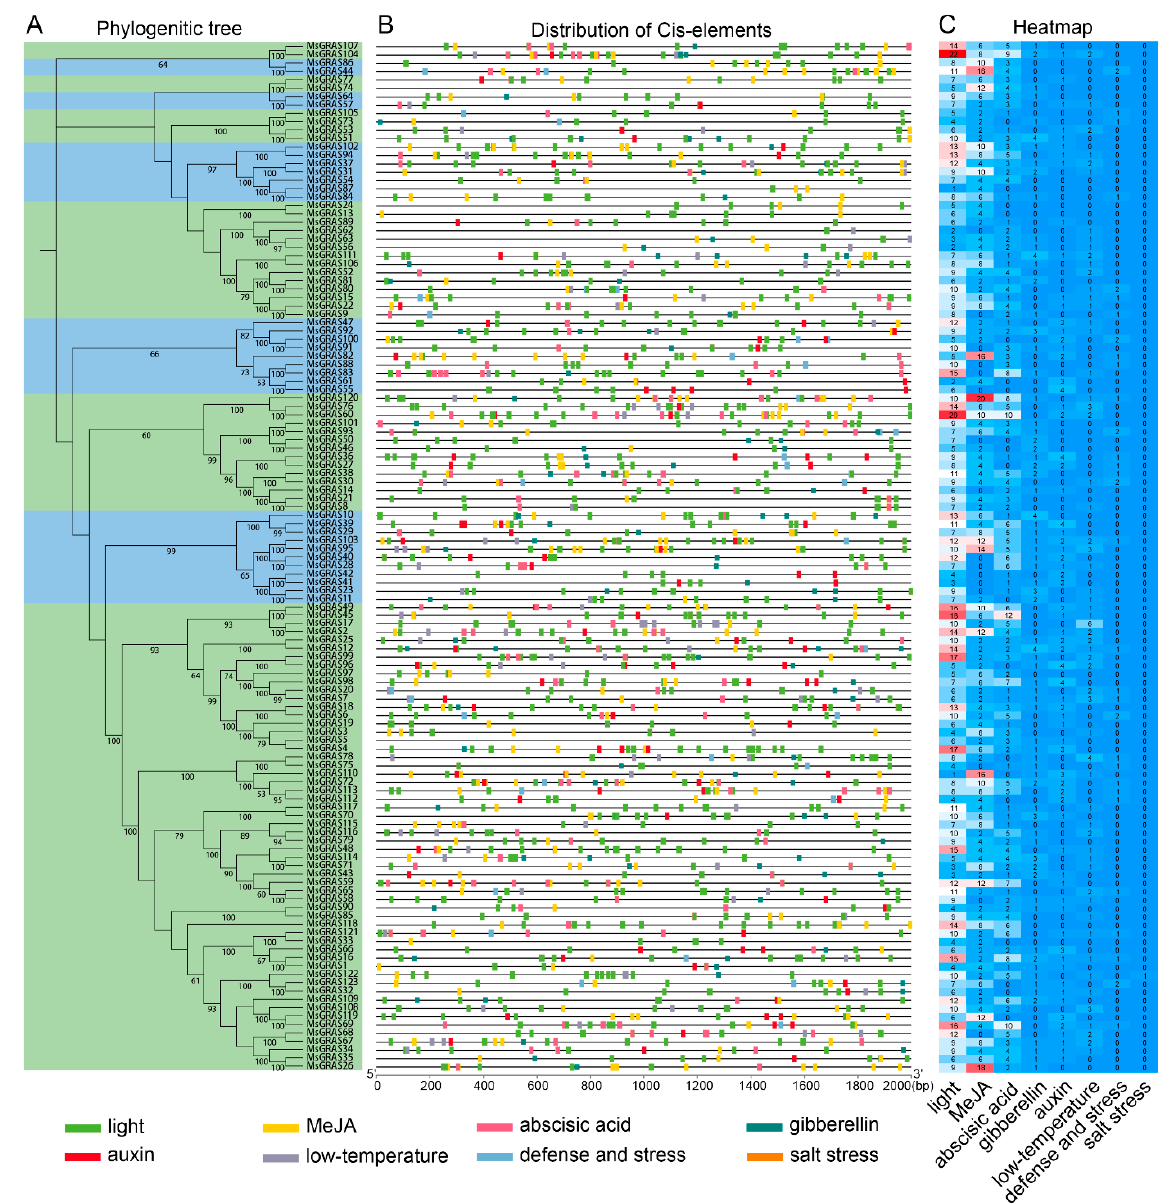
Figure 4. Predicted cis-elements in the promoter sequences of MsGRAS genes. ( A ) Phylogenetic tree of MsGRAS . ( B ) Distributions of cis-elements in MsGRAS promoters. The rectangles with different colors indicate various cis-elements. The number at the bottom indicates the 2000 bp upstream nucleotides to the transcription start codon. ( C ) Heat map showing the occurrence of cis-elements in MsGRAS gene promoters. The scale bar indicates the occurrence of cis-elements with red indicating a larger number and blue denoting a smaller number.